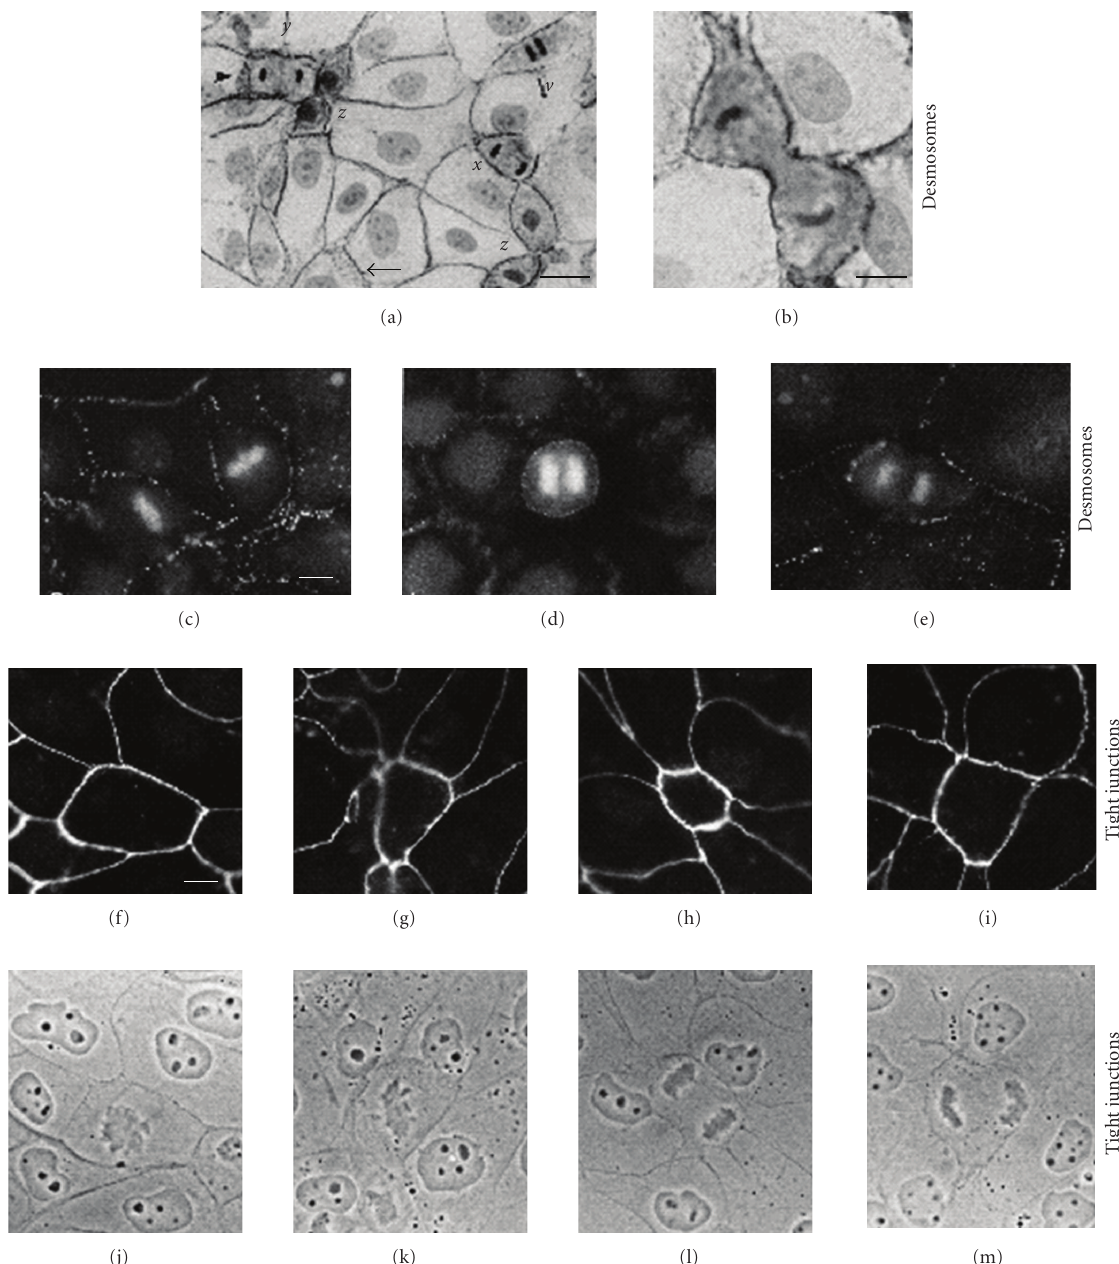
Figure 2: Epithelial cells retain junctional contact during cell division. (a) and (b) MDCK cells stained with monoclonal antibody to desmoplakin by the ABC technique and counterstained with haematoxylin. (a) Cells at various stages of division are shown: w , anaphase; x , telophase; y , early cytokinesis; z , advanced cytokinesis. All dividing cells show prominent peripheral staining for desmoplakin. In some cases (e.g., small arrowhead), the desmoplakin staining is punctate and not obviously confined to the cell periphery. However, similar staining is commonly seen in nondividing cells (e.g., large arrowhead) and appears to be due to oblique viewing of the cell interfaces. (b) High- power photographs of similar cell in advanced cytokinesis. Note the prominent peripheral desmoplakin staining, even at the borders of the cleavage furrow. Although the cytoplasm is generally more darkly staining than that of neighbouring non-dividing cells, this does not indicate desmosome internalisation (see following fluorescence micrographs). Bars: 20m (a) and 10m (b) (c)–(e) MDCK cells stained with monoclonal antibody to desmoplakin and propidium iodide to show chromosomes. (c) Two cells in metaphase, (d) cell in early anaphase, and (e) cell in late anaphase. All dividing cells show peripheral punctate staining for desmoplakin, comparable to that seen in non-dividing neighbours. However, no punctate staining indicative of desmosome internalisation is present in the cytoplasm of the dividing cells. Bar: 10m. (f)–(i) MDCK cells stained with monoclonal antibody to tight junction protein ZO-1. (j)–(m) Corresponding phase-contrast images. The cell in (F,J) is in prophase, that in (g) and (k) in metaphase and those in the remaining pictures in telophase. Each dividing cell is surrounded by a complete ring of ZO-1 staining and shows no evidence of junction internalization or disruption. Dividing cells in epidermis and intestine also showed retention of junctions by electron microscopy. Bar: 10 m. Reproduced from the study by Baker and Garrod in